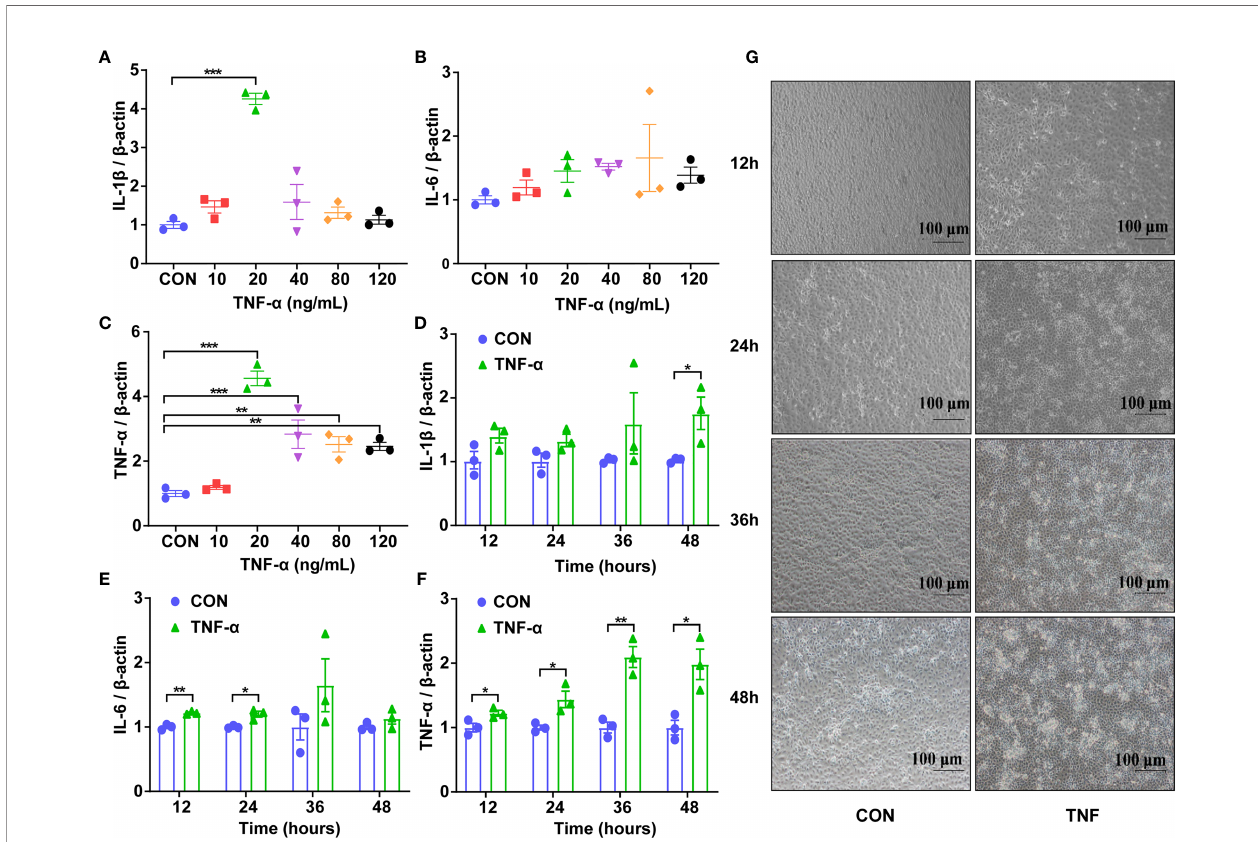
FIGURE 2 | Expression of genes encoding in fl ammatory cytokines and the representative morphology of IPEC-J2 cells in different groups. (A) The mRNA level of IL- 1 b of cells challenged with Recombinant Susscrofa TNF- a with different concentrations (0, 10, 20, 40, 80, 120 ng/mL) for 48 h. (B) The mRNA level of IL-6 of cells challenged with TNF- a with different concentrations (0, 10, 20, 40, 80, 120 ng/mL) for 48 h. (C) The mRNA level of TNF- a of cells challenged with TNF- a with different concentrations (0, 10, 20, 40, 80, 120 ng/mL) for 48 h. (D) The mRNA level of IL-1 b of cells challenged with 20 ng/mL TNF- a for 12, 24, 36 and 48 h. (E) The mRNA level of IL-6 of cells challenged with 20 ng/mL TNF- a for 12, 24, 36 and 48 h. (F) The mRNA level of TNF- a of cells challenged with 20-ng/mL TNF- a for 12, 24, 36 and 48 h. Data are represented as mean ± SEM (n = 3). * P < 0.05, ** P < 0.01, *** P < 0.001. CON, cells without TNF- a treatment. Results represented one of the three independent experiments. (G) The representative images of IPEC-J2 cells challenged with 20 ng/mL Recombinant Susscrofa TNF- a photographed by an inverted microscope under bright fi eld at 12, 24, 36 and 48 h, respectively. The scale bar is 100 m